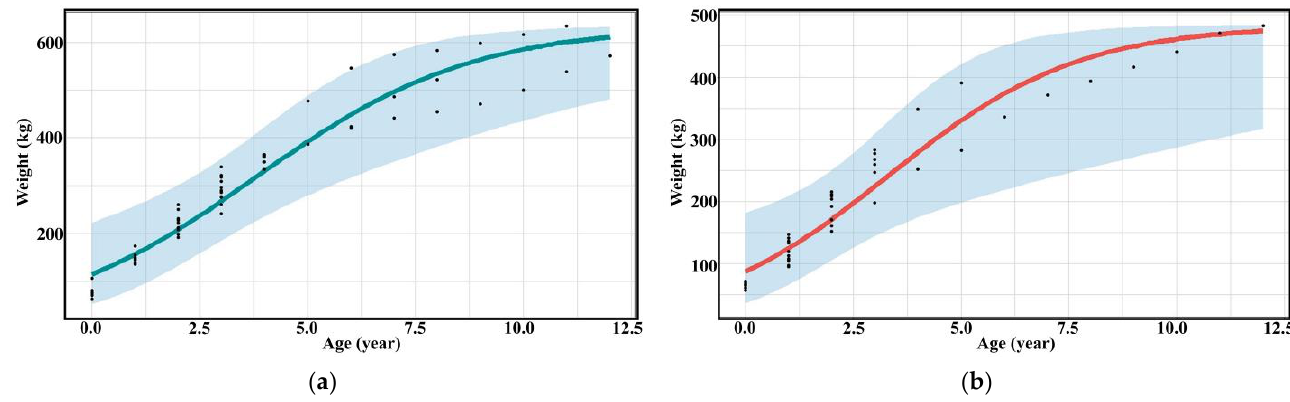
Figure 3. Relationship between age and weight of ( a ) male and ( b ) female captive banteng by re- Figure 3. Scatter diagram (black dots) with regression line of the relationship between age and weight searchers. of ( a ) male and ( b ) female captive banteng by researchers.